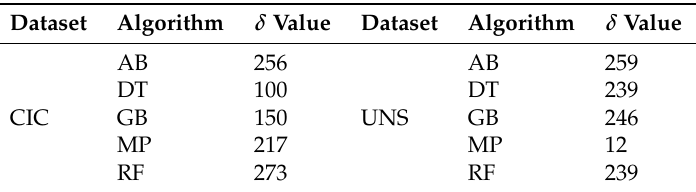
Table 14. Optimal δ value detection—additional